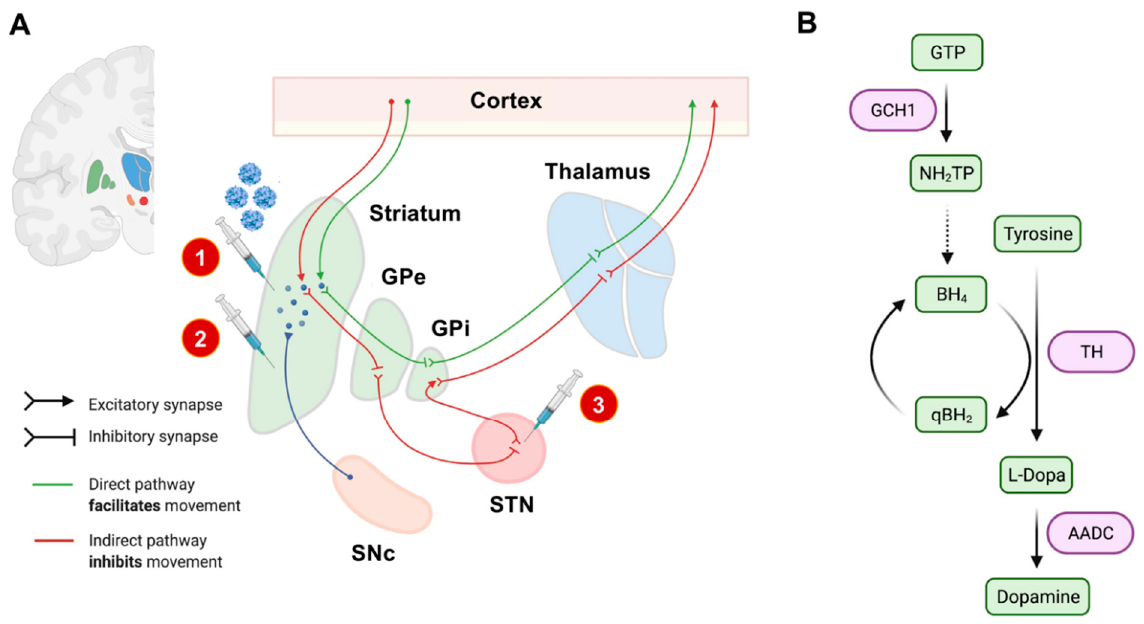
Figure 1. Experimental gene therapeutic approaches for the treatment of PD. In ( A ), neuroanatomical target regions and their functional interconnections are schematically depicted. So far, mainly two target sites have been evaluated: the striatum and the subthalamic nucleus (STN). Different treatment strategies and injection sites are highlighted by syringes. The red circled numbers refer to the numbered list of currently employed gene therapeutic strategies: 1. enhancement of dopamine production, 2. delivery of neurotrophic factors, and 3. overexpression of GAD to modulate basal ganglia loops. The SNc has not yet been evaluated as an injection site, mainly based on its limited accessibility by stereotactic surgery. In ( B ), we schematically highlighted the currently considered strategies for enhancing dopamine synthesis. The so-far investigated dopamine metabolism-related enzymes and their respective role in dopamine synthesis are highlighted in purple. AADC: L-amino acid decarboxylase. BH 4 : Tetrahydrobiopterin. GCH1: GTP cyclohydrolase I. GPe: external globus pallidus. GPi: internal globus pallidus. GTP: guanosine triphosphate. NH 2 TP: dihydroneopterin triphosphate. PD: Parkinson’s disease. eqBH 2 : quinoid dihydrobiopterin. SNc: substantia nigra pars compacta. STN: subthalamic nucleus. TH: tyrosine hydroxylase.